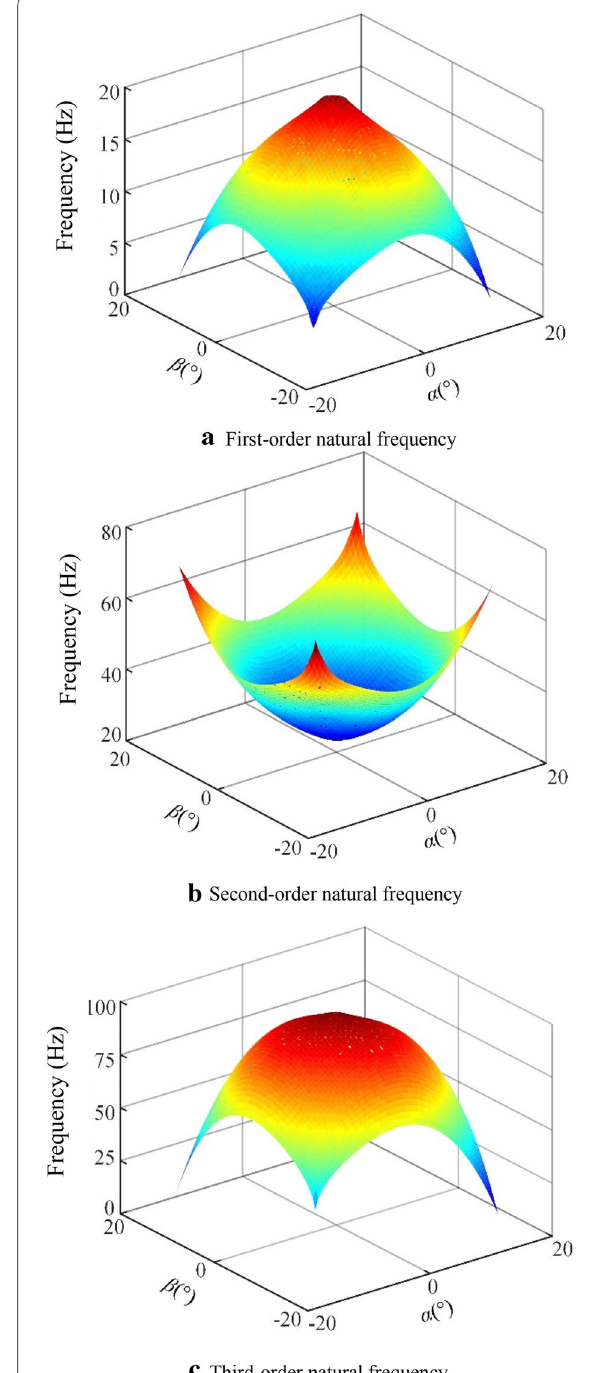
Figure 8 Natural frequency distribution of the 5-PSS/UPU parallel mechanism attitude